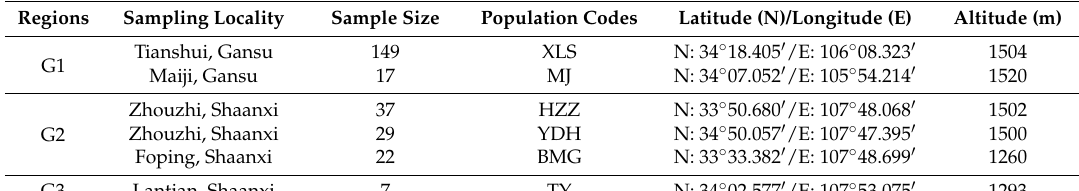
Table 1. Summary of A. miaotaiense sampling locations in China.